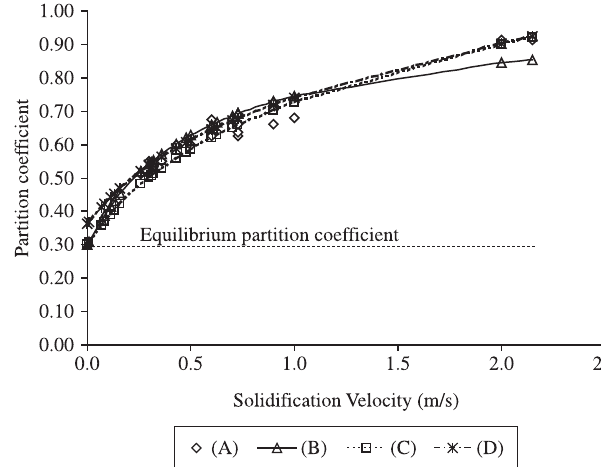
Figure 7. The effect of solidification velocity on As partition coefficient in Si-As alloy : A) experimental 8 ; B) equation 2 ,4 and 5 using K C) Sobolev’s fitting; and D) Galenkos’s fitting.